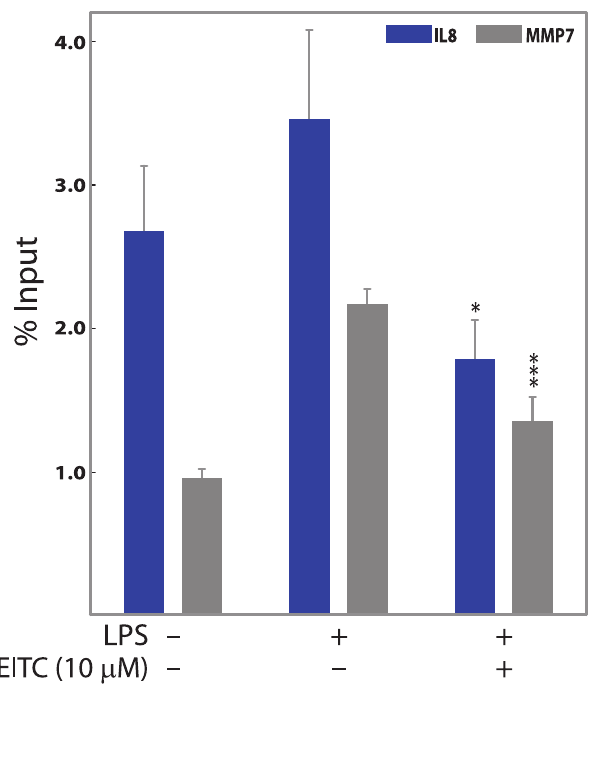
Figure 4. Histone H3 acetylation changes at the promoter region of genes of interest (GoI) in SW480 cells. Chromatin from SW480 cells was harvested after 5 h of 10 m M PEITC treatment. Out of 13 GoIs tested in SW480 cells, two genes showed statistically significant PEITC-associated changes in H3-Ac status. The results of ChIP analyses using an anti-acetyl-Histone H3 antibody are shown. DNA sequences were quantified by real- time PCR using promoter primers. Average percentage input 6 SEM (n=3) from each experiment is plotted. *p , 0.05, ***p , 0.001 compared with positive-control cells.